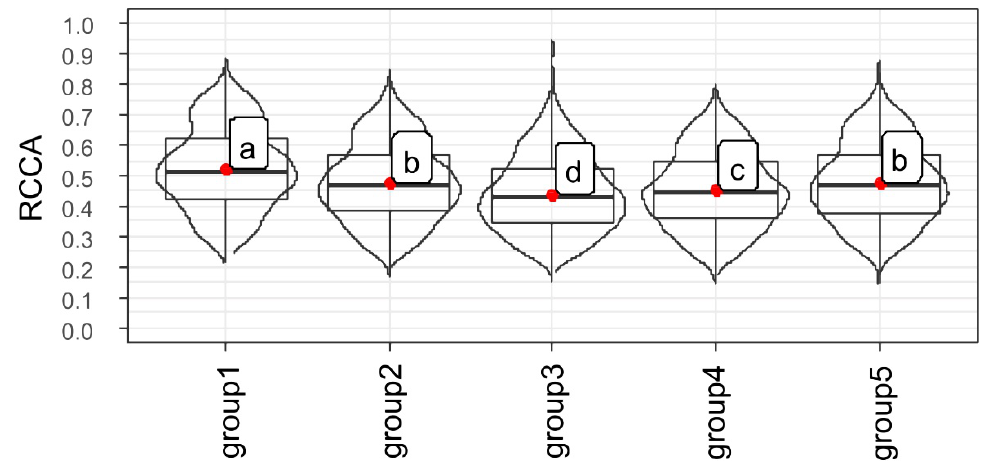
Figure 8. First eigenvalue of the Regulatory canonical correlation (RCCA) from the computational process Bootstrap 10,000 generated from each gene group (1, 2, 3, 4 and 5) with aspects of soybean seed vigor expression. Distinct letters indicate a significant difference at the 5% probability level ( p < 0.05). Group 1: N-glycosylase/DNA lyase OGG1 ( OGG1 ), Expansin-like A1 ( EXPA1 ), Xyloglucan endotransglucosylase/hydrolase 22 ( XTH22 ), Xyloglucan endotransglucosylase/hydrolase 2 ( XTH2 ), 65-kDa microtubule-associated protein ( microtubule ), Cellulose synthase A catalytic subunit 2 ( cellulose ). Group 2: DNA apurinic , Metallothionein-like protein 1 ( MT1 ), Enolase , LRR receptor-like serine/threonine-protein kinase FEI ( FEI1 ). Group 3: NAC domain-containing protein 8-like ( SOG1 ), Expansin-A10-like ( EXPA10 ), Alpha-xylosidase 1-like ( XYL1 ). Group 4: Endoglucanase 8-like ( Egnase ), Cysteine proteinase RD21a-like ( RD21a-like ), Thiol protease aleurain-like ( Thiol ). Group 5: Tubulin alpha-4 chain-like ( TUA ), Expansin-like A6 ( EXPA6 ), Pectinesterase 3 ( PME ), Beta-1,3-galactosyltransferase 20 ( GALT20 ).